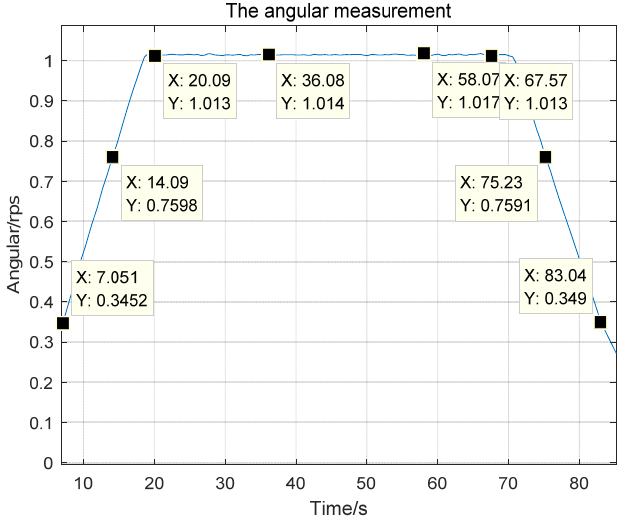
Figure 7. Instantaneous intermediate coil angular speed output by the magnetic sensor electronic solver module.